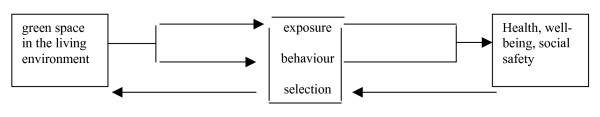
General mechanisms to explain relationships between green space and health, well-being and social safety.